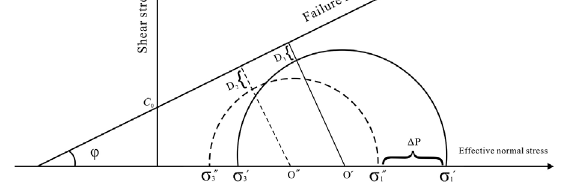
FIGURE 2 Mohr – Coulomb plot of the stress state change during fracturing liquid injection. σ 1 ′ and σ 3 ′ are the initial effective stresses, σ 1 ʺ and σ 3 ʺ are the effective stresses changed by pore pressure, and D 1 and D 2 are the failure margin